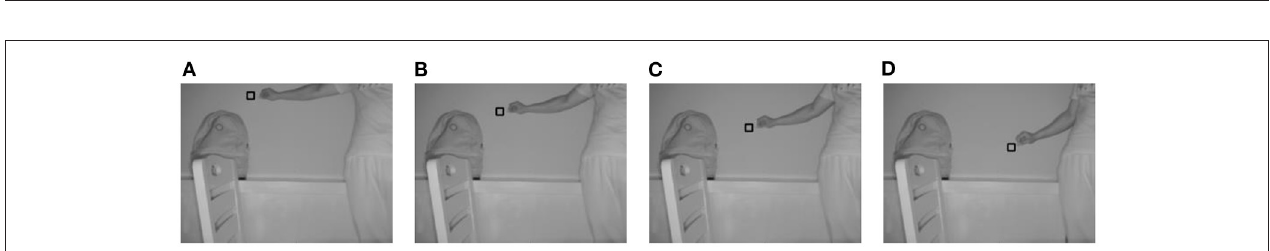
FIGURE 3 | Tracking results from the method of thresholding the data source into which depth information is introduced. (A) The 10th frame; (B) the 30th frame; (C) the 50th frame; (D) the 80th frame.